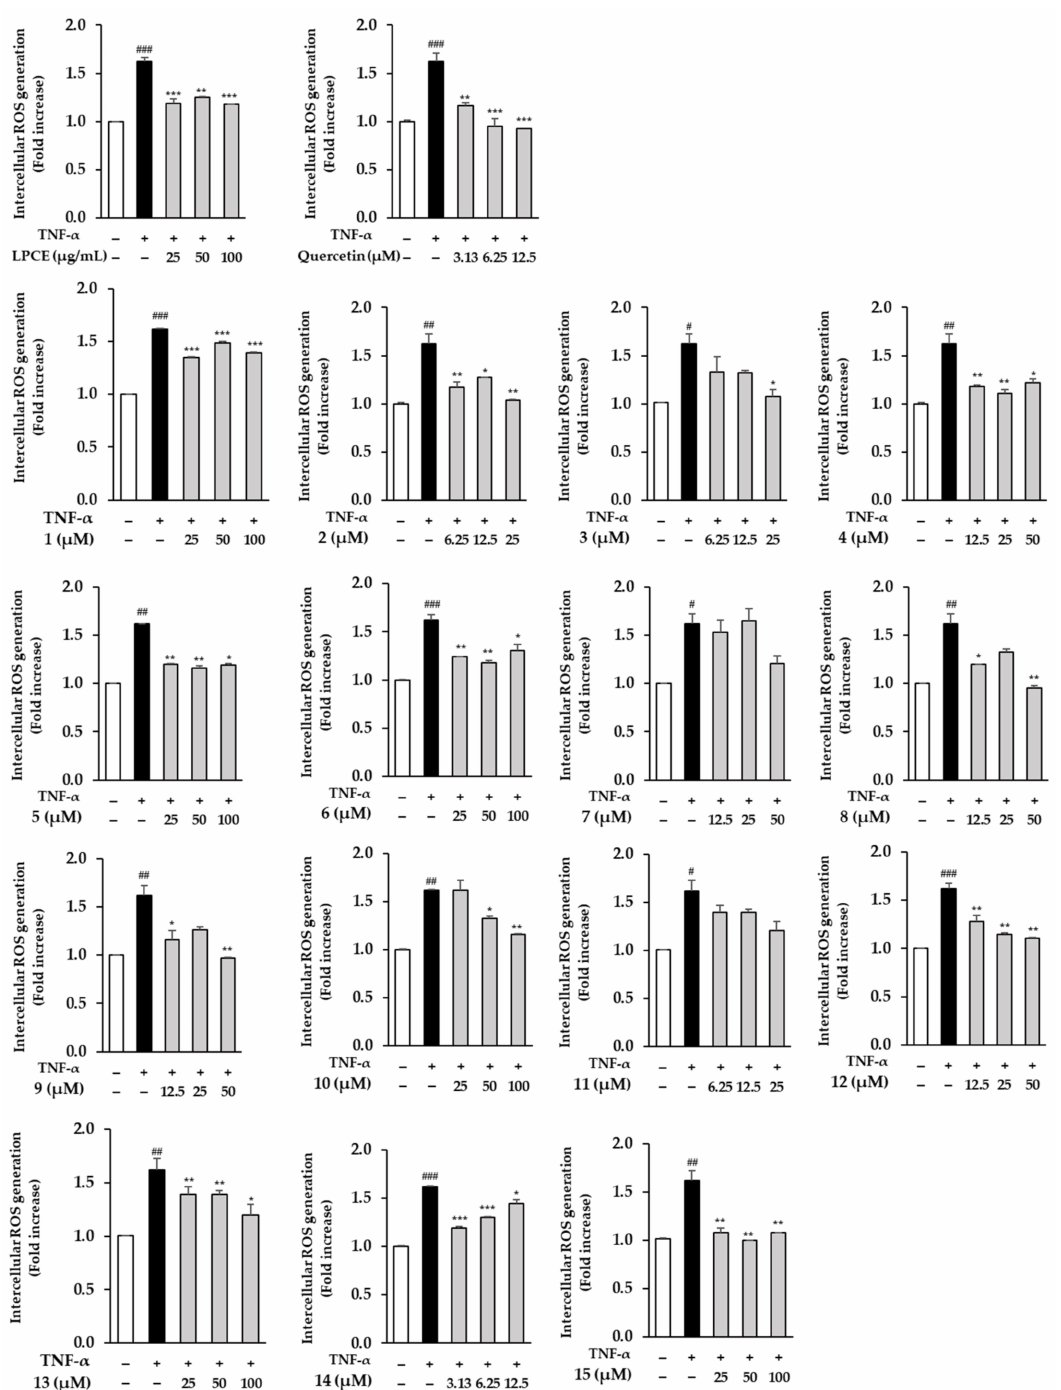
Figure 4. Inhibitory effect of the extract (LPCE) and isolates ( 1 – 15 ) from P. chinensis on intracel- lular ROS generation in TNF- α -induced HDFs. The HDF cells were plated at a concentration of 1 × 10 4 cells/well in a black 96-well plate and incubated for 24 h. The previous media were ex- changed with fresh media without FBS for 24 h for cell cycle arrest. After that, LPCE and isolates were treated with the indicated concentration for 1 h, and continuously cotreated with 20 ng/mL of TNF- α and 10 µ M of the probe dichlorofluorescin diacetate (DCFDA) for 15 min. The data are presented as mean ± SEM ( n = 2). ### p < 0.001, ## p < 0.01 and # p < 0.05 compared with the untreated group; *** p < 0.001, ** p < 0.01 and * p < 0.05 compared with the TNF- α -treated group. Quercetin was used as a positive